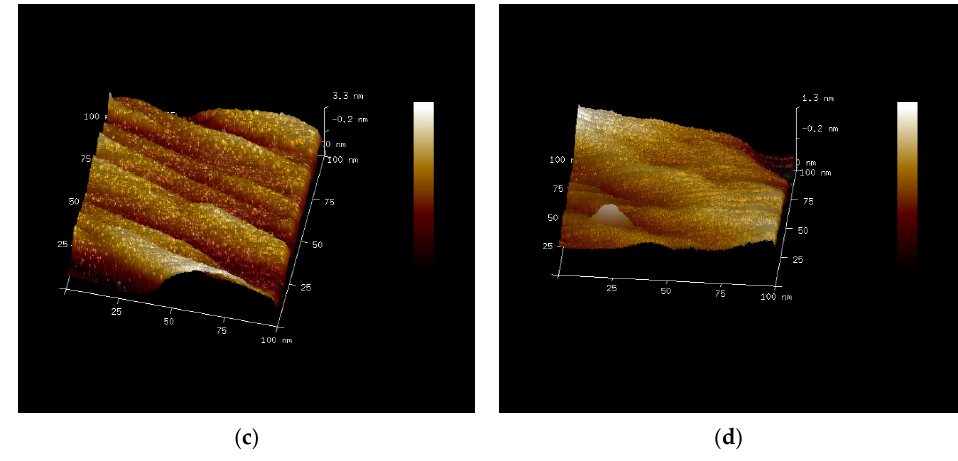
Figure 6. Atomic force microscope (AFM) images of the samples: ( a ) TiO 2 ; ( b ) Ti 0.9 Hf 0.1 O 2 ; ( c ) Ti 0.25 Hf 0.75 O 2 ; and ( d ) HfO 2 . The roughness ( R rms ) for each sample is 0.325 nm, 0.431 nm, 0.425 nm, and 0.202 nm.